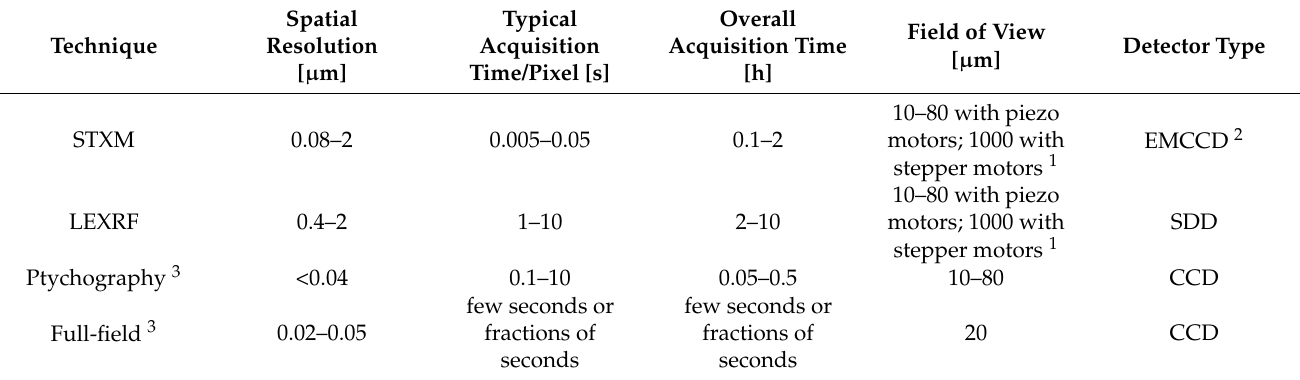
Table 1. Summary of TwinMic